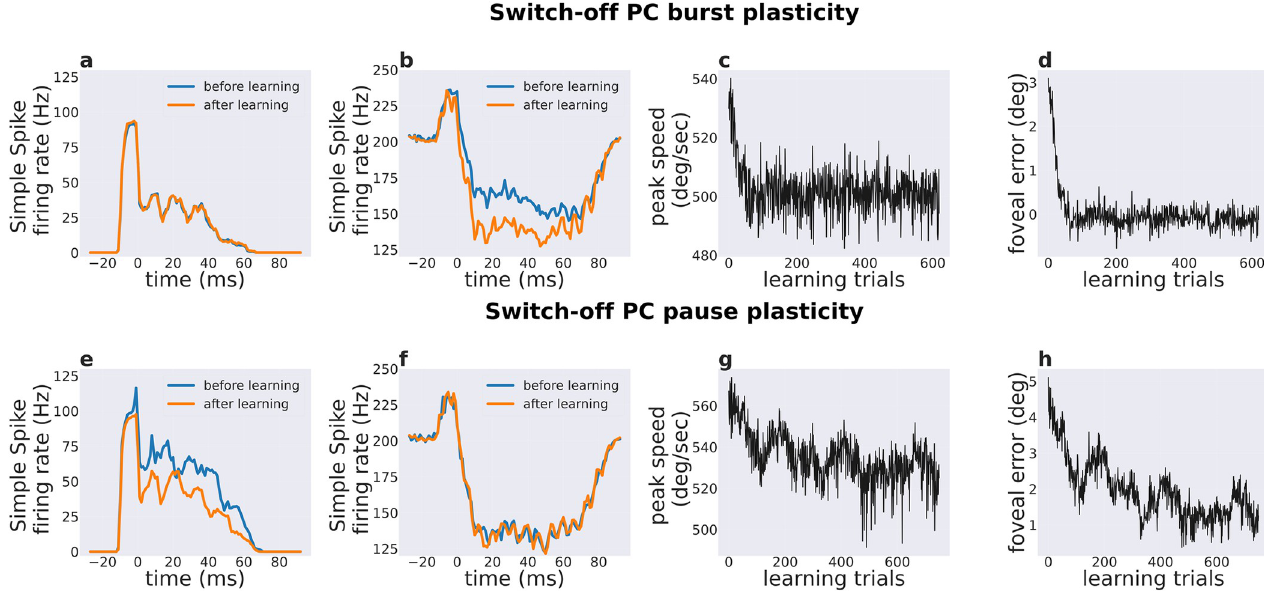
Fig 6. Effect of selectively switching-off of dual plasticity process in each PC subpopulation on the PC population activity and saccade kinematics. Simple spike activity before and after training in a, e) the burst PC subpopulation when switching-off burst or pause PC plasticity and in b, f) the pause PC subpopulation when switching-off burst or pause PC plasticity. c, g) Peak eye speed across learning trials when switching-off burst or pause PC plasticity d, h) Foveal error across training trials by switching-off burst or pause PC plasticity.